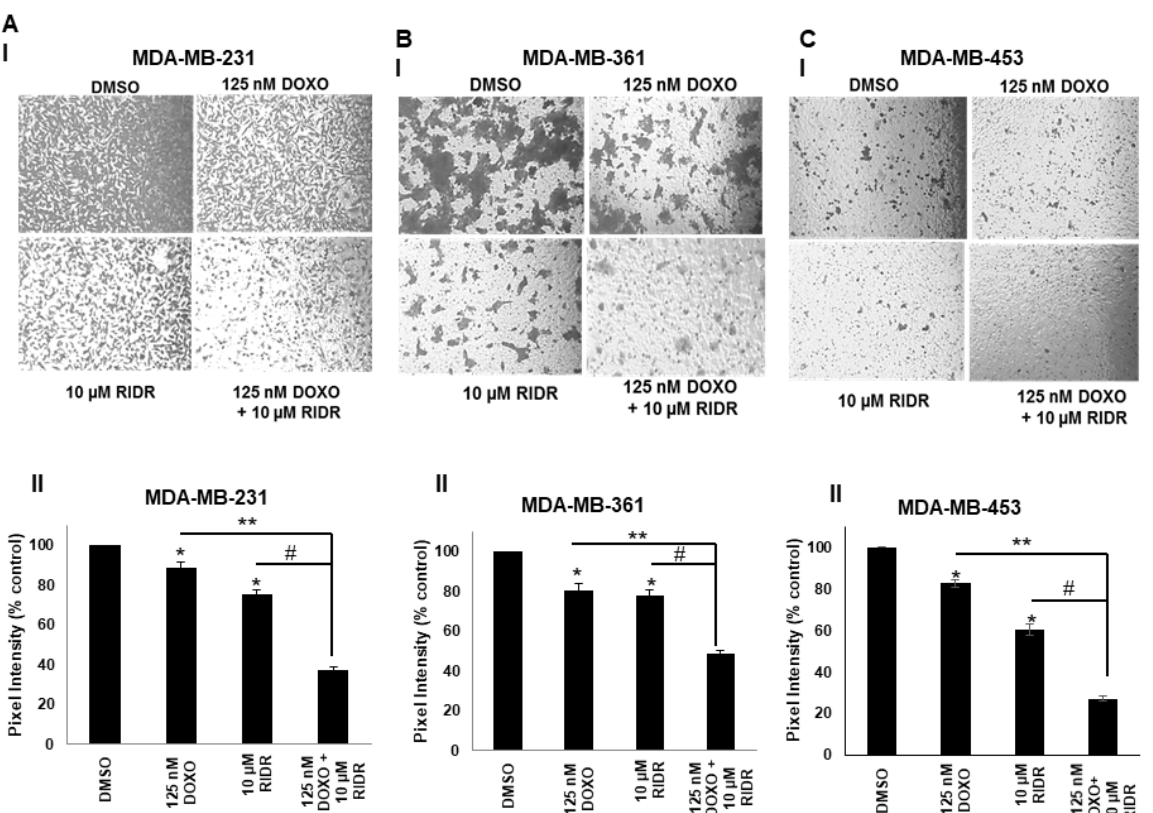
Figure 5. Doxorubicin and RIDR-PI-103 suppress breast cancer cell migration. ( A ) MDA-MB-231 cells were seeded at a density of 5 × 10 4 cells/well and treated with vehicle (DMSO), doxorubicin (125 nM), RIDR-PI-103 (10 µM) and indicated combination in serum free media for 24 h. ( B ) MDA-MB-361 cells were seeded at the same density and treated with indicated combination in serum free media for 24 h. ( C ) MDA-MB-453 cells were seeded at a density of 5 × 10 4 cells/well and treated with vehicle (DMSO), doxorubicin (125 nM), RIDR-PI-103 (10 µM) and indicated combination in serum free media for 48 h. 10% FBS was added as a chemoattractant in the lower chamber. After 24–48 h, the migrated cells were stained and intensities were measured using ImageJ and expressed as % of control (panel I). The bar graphs are represented as mean; Error bars: SEM ( n = 3 independent experiments performed in triplicate), p -value < 0.05 for comparison of * to DMSO, ** for comparison of doxorubicin versus doxorubicin and RIDR-PI-103, # for comparison of RIDR-PI-103 versus doxorubicin and RIDR-PI-103 (panel II).